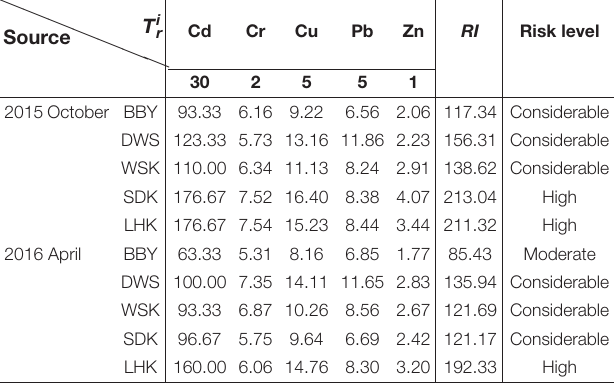
TABLE 2 | Potential ecological risk factor ( E i r ), risk indices ( RI ), and risk levels of heavy metals in the intertidal sediments at Yangtze River estuary. (cid:97) (cid:97) (cid:97) (cid:97) (cid:97) (cid:97) (cid:97)